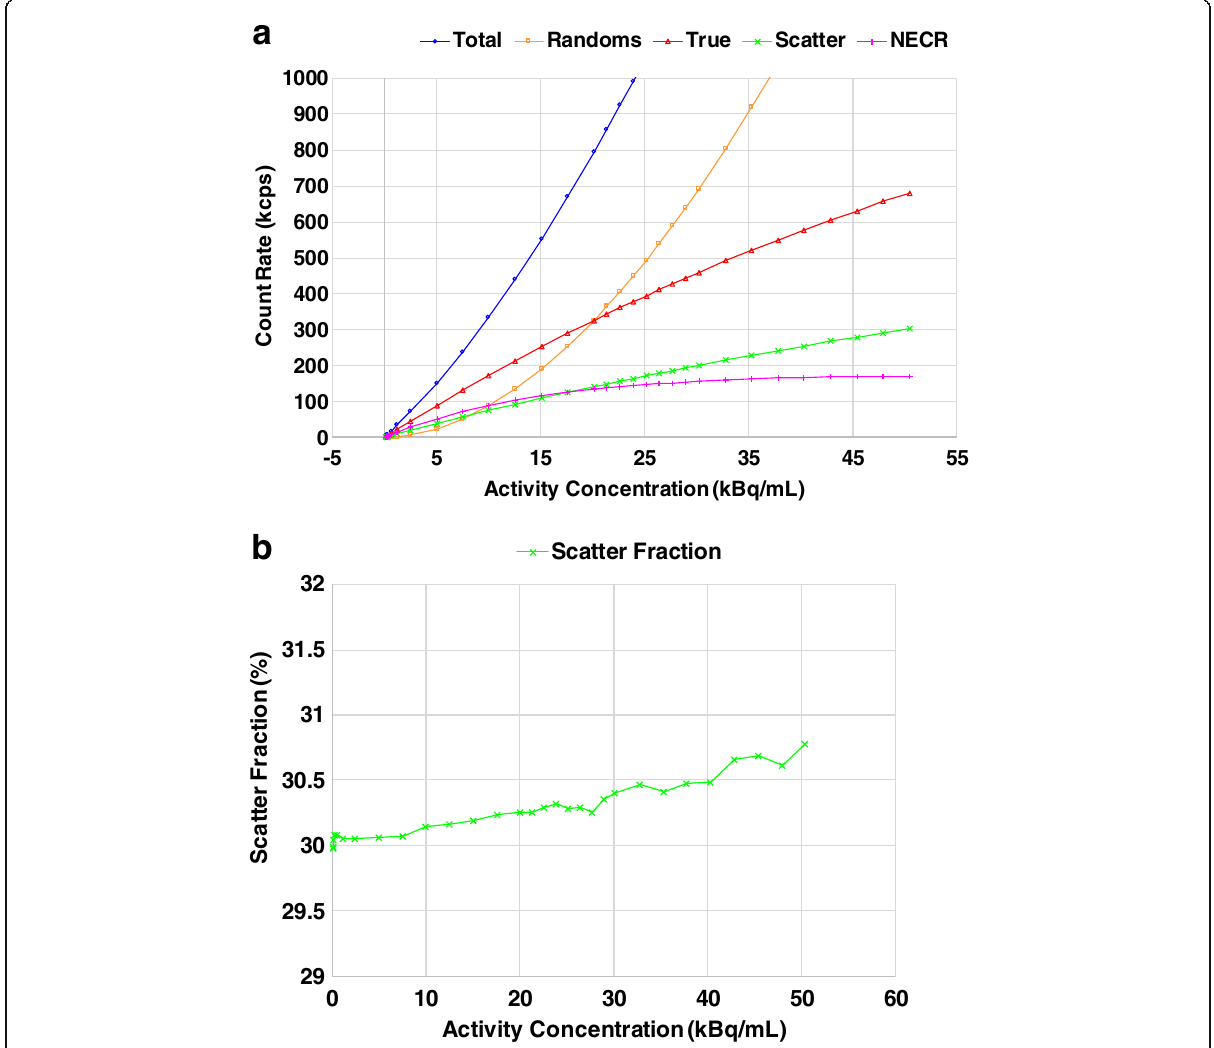
Fig. 5 NEMA count rate measurements as a function of activity concentration. a Count rate of total, randoms, true, and NECR. b Scatter